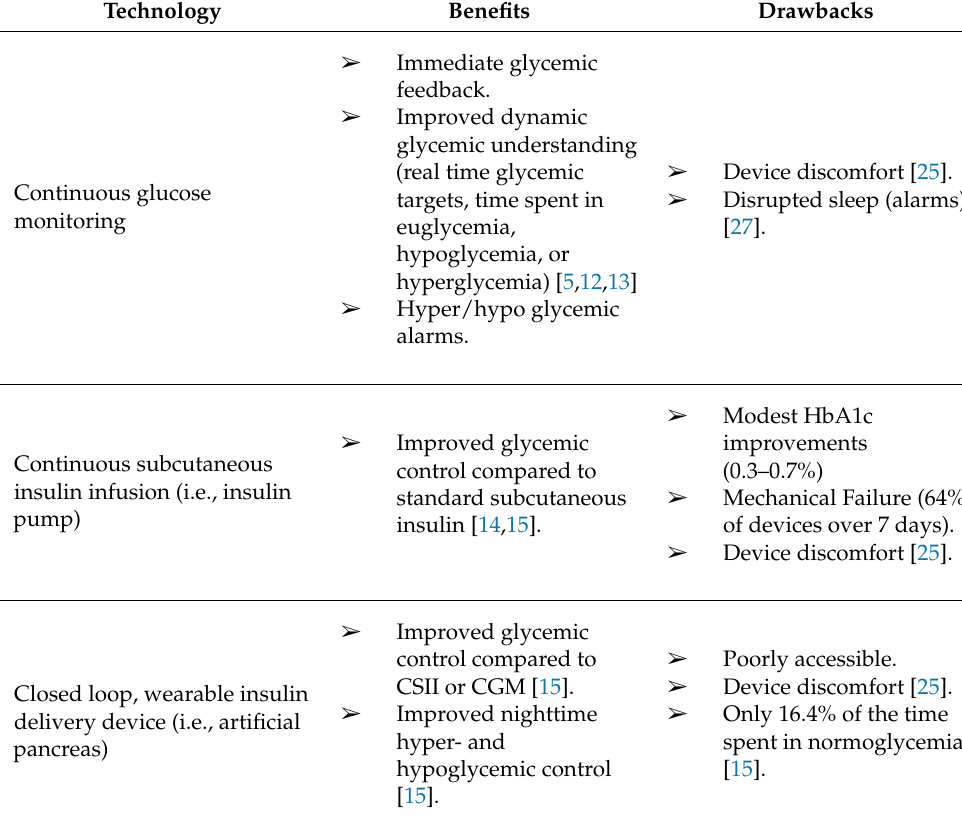
Table 1. Benefits and drawbacks of novel subcutaneous insulin monitoring and delivery